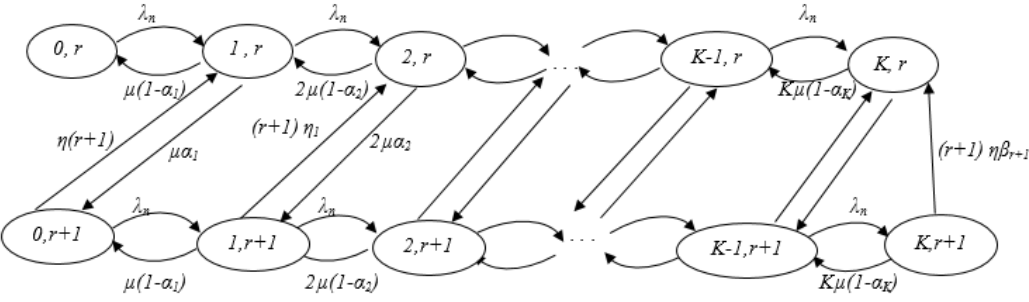
Figure 2. Fragment of the transition graph for the splitting model with state space E n .